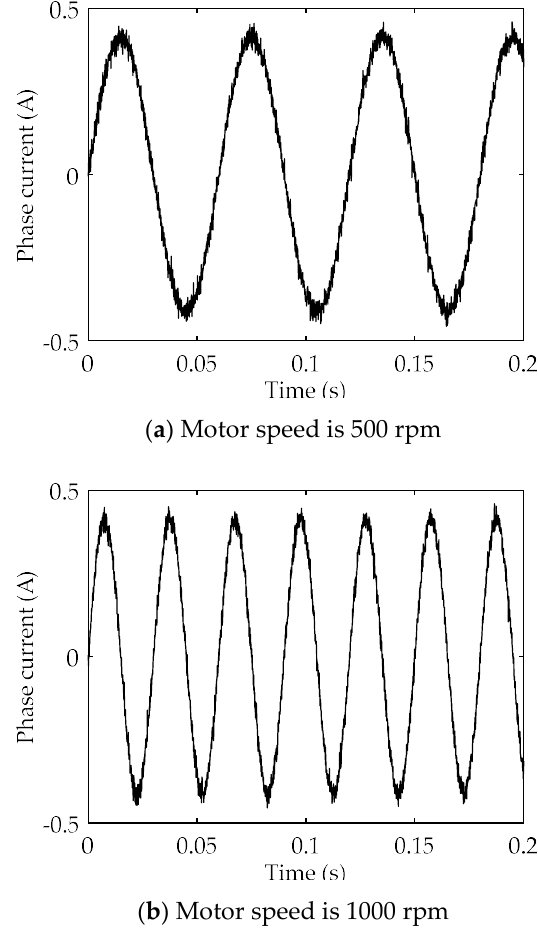
Figure 8. Phase currents when the motor speed is ( a ) 500 rpm and ( b ) 1000 rpm